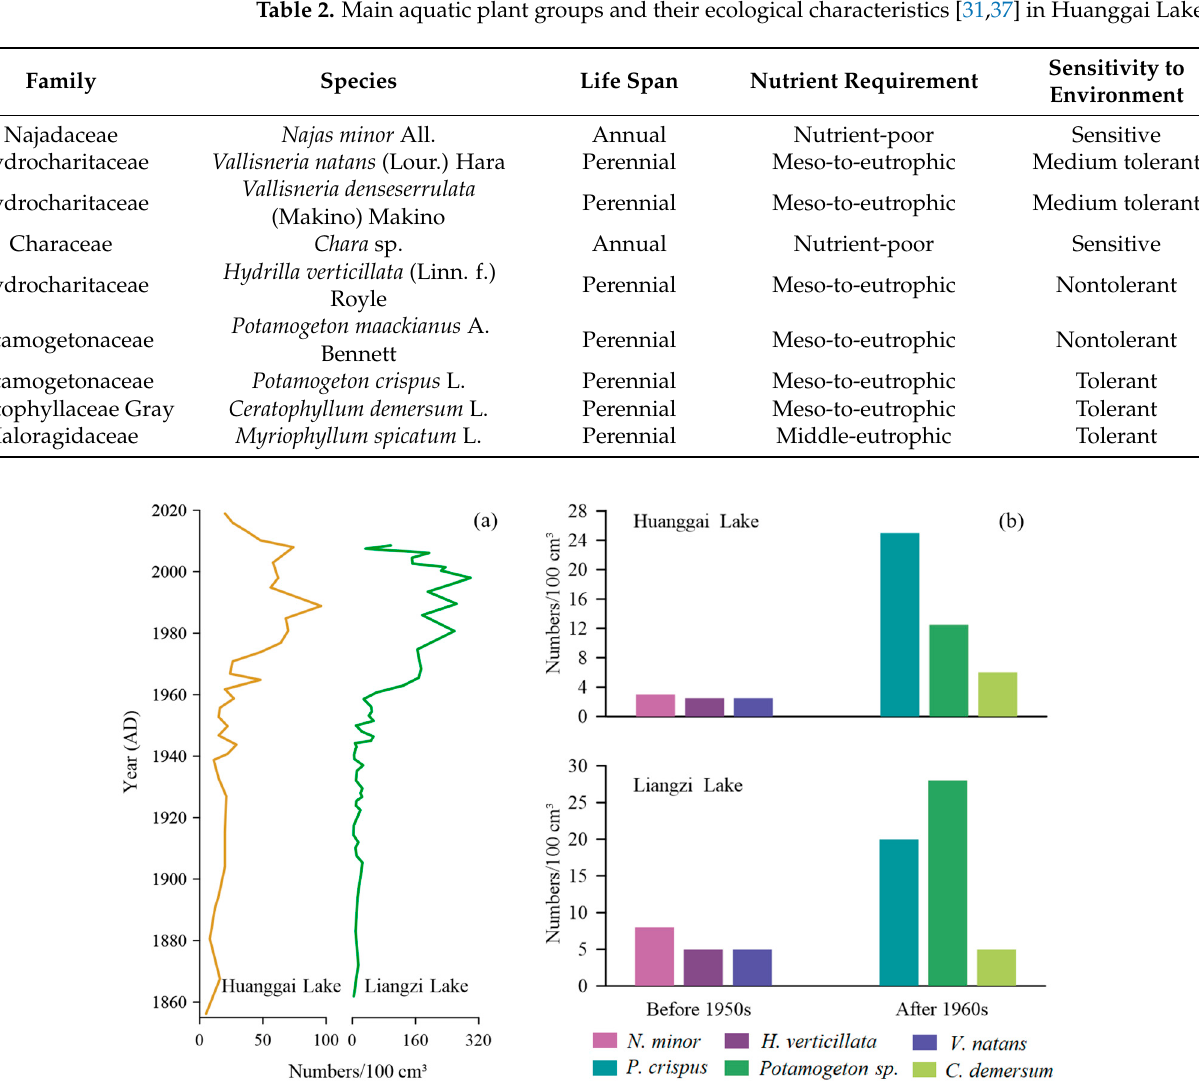
Figure 7. Comparison of plant macrofossil characteristics between Huanggai Lake and Liangzi Lake in different periods: ( a ) temporal trend of total concentration; ( b ) average concentration of main aquatic plant species in two different periods (natural condition before 1950 and stronger human impact after 1960s).